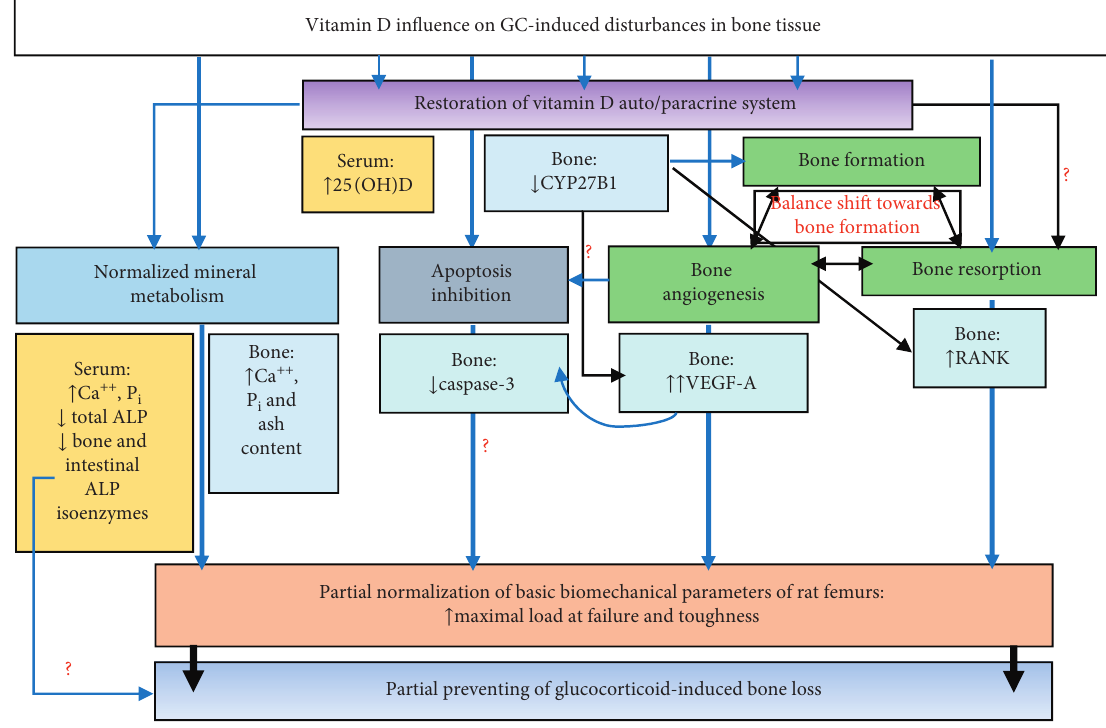
Figure 6: A schematic summary of the results obtained in the study. Osteoporosis was characterized by an impairment of angiogenesis/ osteoblastogenesis/osteoclastogenesis coupling that led to a decrease in whole-bone biomechanical parameters of femurs and bone turnover characteristics; vitamin D 3 demonstrated ameliorative action in prednisolone-induced osteoporosis. 25(OH)D: 25-dihydroxyvitamin D; ALP: alkaline phosphatase; Ca ++ : calcium; CYP27B1: 25(OH)D-1 α -hydroxylase; P i : inorganic phosphate; RANK: receptor activator of nuclear factor κ B; VDR: vitamin D receptor; VEGF-A: vascular endothelial growth factor A. Blue normal arrows indicate a positive effect; black normal arrows indicate a link/influence; ⟶ : direct; ↔ :bidirectional; ?:points that need to be addressed by future